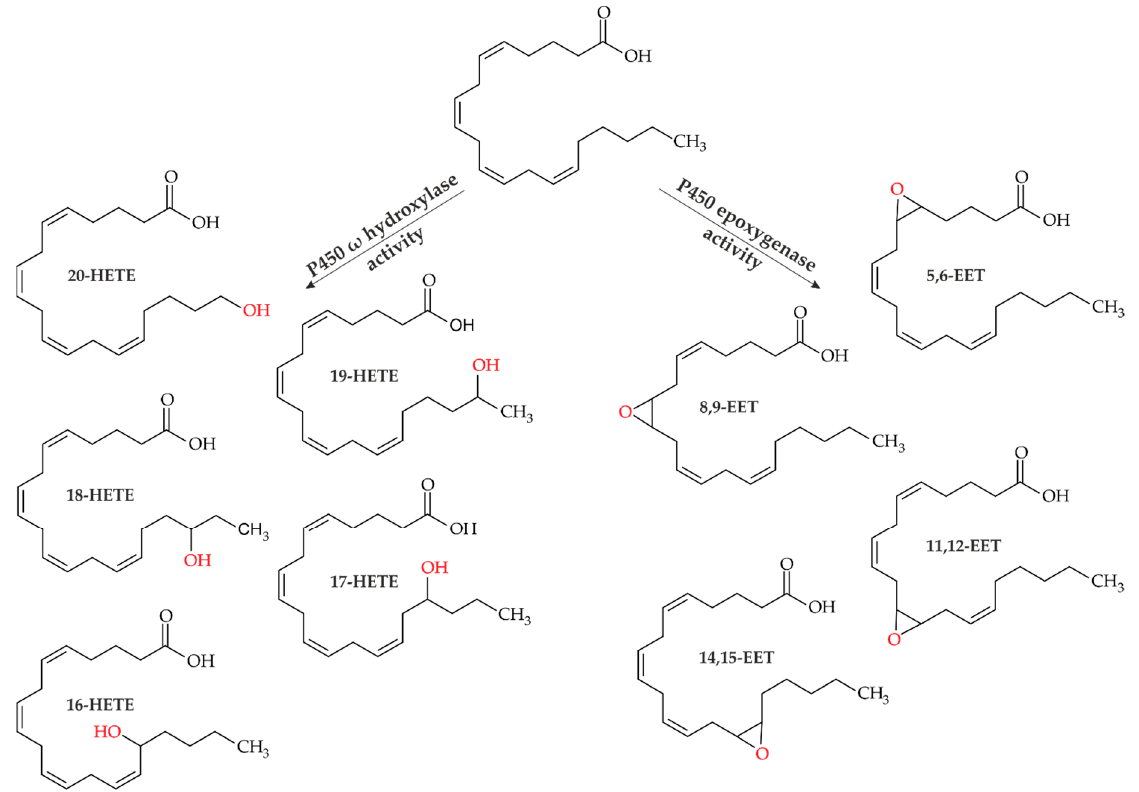
Figure 1. Arachidonic acid metabolism by cytochrome P450 monooxygenases. Left site: Hydroxyeicosatetraenoic acids (HETEs) 16-, 17-, 18-, 19-, 20-HETE formed by P450 ω -hydroxylase activity. Right site: Epoxyeicosatrienoic acids (EETs) 5,6-EET, 8,9-EET, 11,12-EET and 14,15-EET formed by P450 epoxygenase activity.